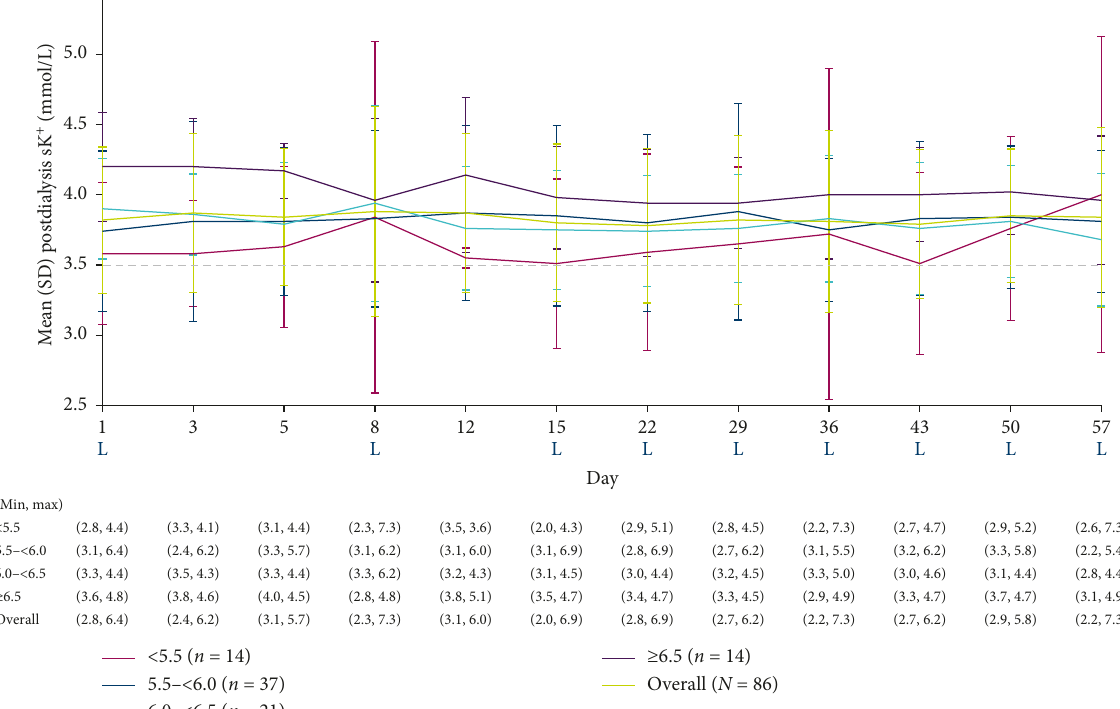
Figure 4: Postdialysis sK + concentration at each study visit in placebo patients overall and by predialysis sK + concentration at ran- domization. Predialysis sK + measurement at randomization (visit 4, day 1) was used for subgroup stratification. No imputation of missing data was conducted. The dashed line represents the threshold for hypokalemia (i.e., sK + 3.5mmol/L). L represents the LIDI visits. LIDI, long interdialytic interval; SD, standard deviation; sK + , serum potassium.